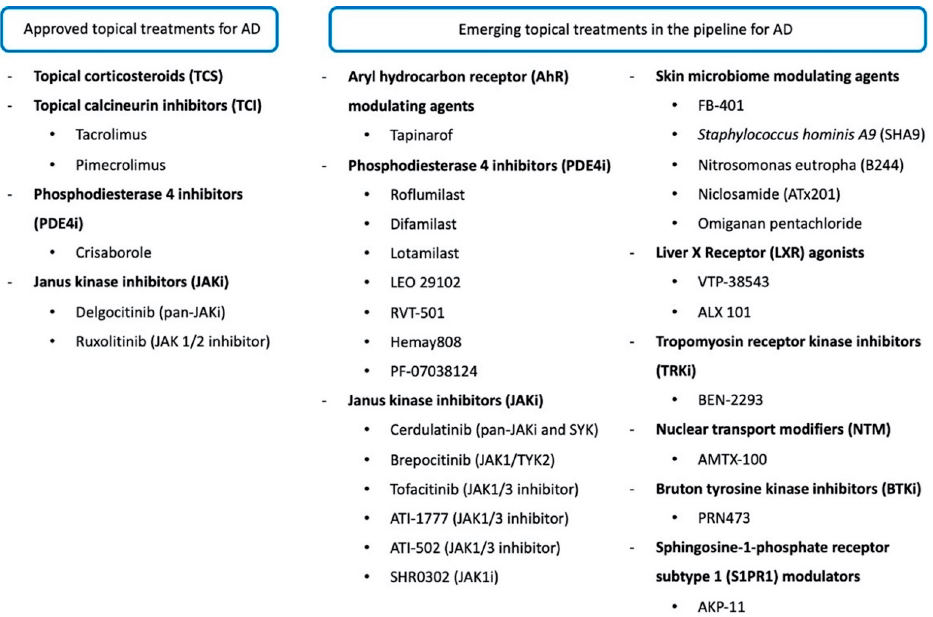
Figure 1. Currently approved and emerging topical treatments for atopic dermatitis. Abbreviations: AD, atopic dermatitis; SYK, spleen tyrosine kinase; TYK2, tyrosine kinase 2.